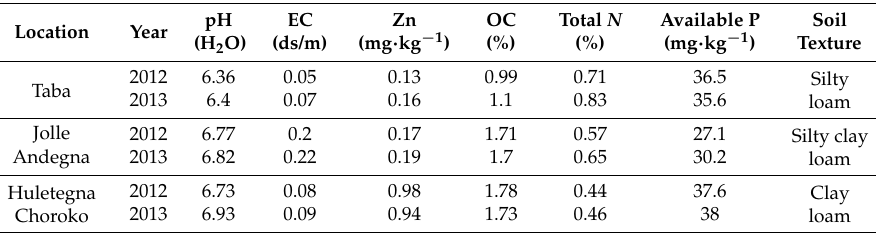
Table 10. Soil properties of the experimental sites at each location in 2012 and 2013.